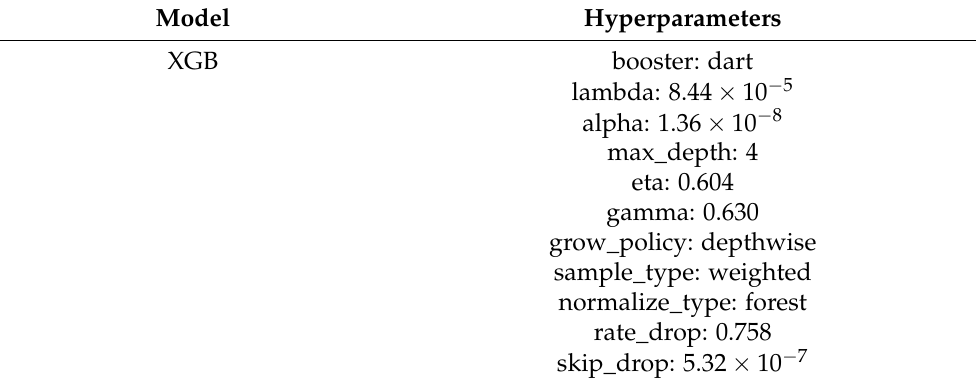
Table A9. Optimal hyperparameters for all ML models attained through tuning for the 8 feature EHR